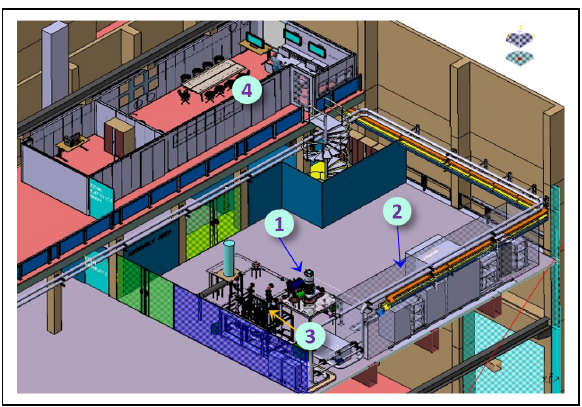
Fig. 1 : ITER-India Gyrotron Test Facility layout (1: Gyrotron set-up; 2: HV area; 3: Cooling Manifold; 4: Control room)